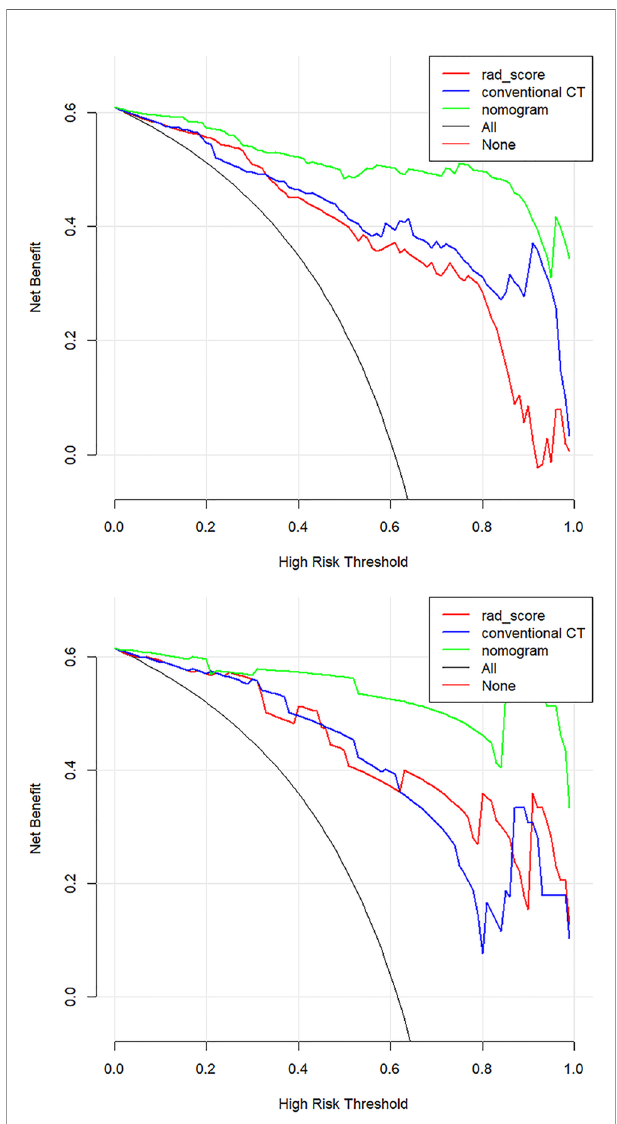
FIGURE 7 | Decision curve analysis (DCA) for the three models. The net bene fi t versus the threshold probability was plotted. The x-axis represents the threshold probability, while the y-axis represents the net bene fi ts. The sensitivity and speci fi city of the model are calculated at each threshold to determine the net bene fi t. The DCAs showed that the net bene fi ts of the nomogram model (green line) were superior to the bene fi ts of the conventional CT model (blue line) and the Rad-score based model (red line) with the threshold probability range from 0 to